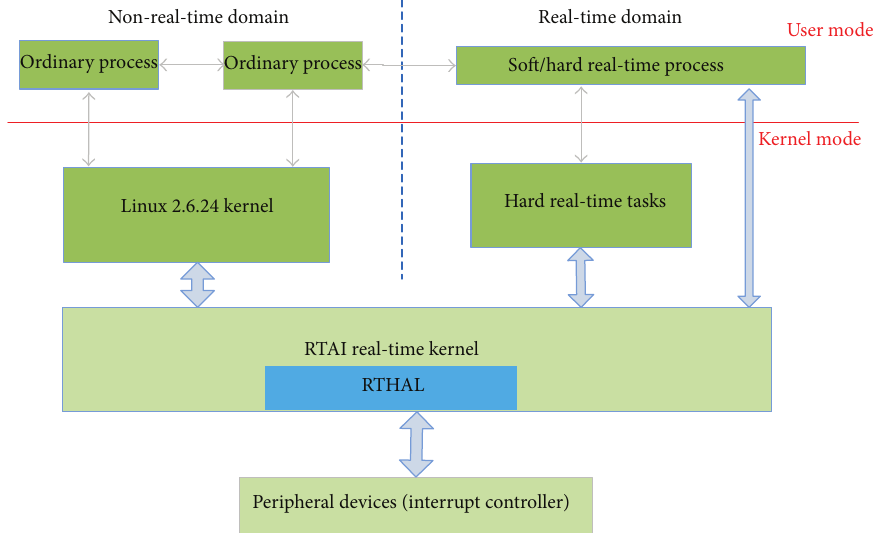
Figure 5: Dual kernel hard real-time